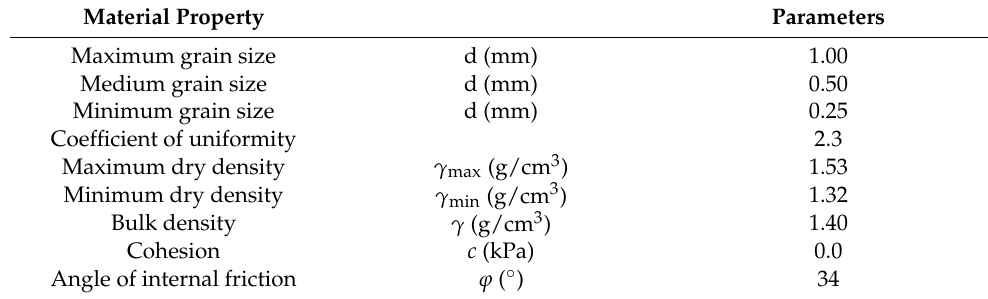
Table 2. Key parameters of dry